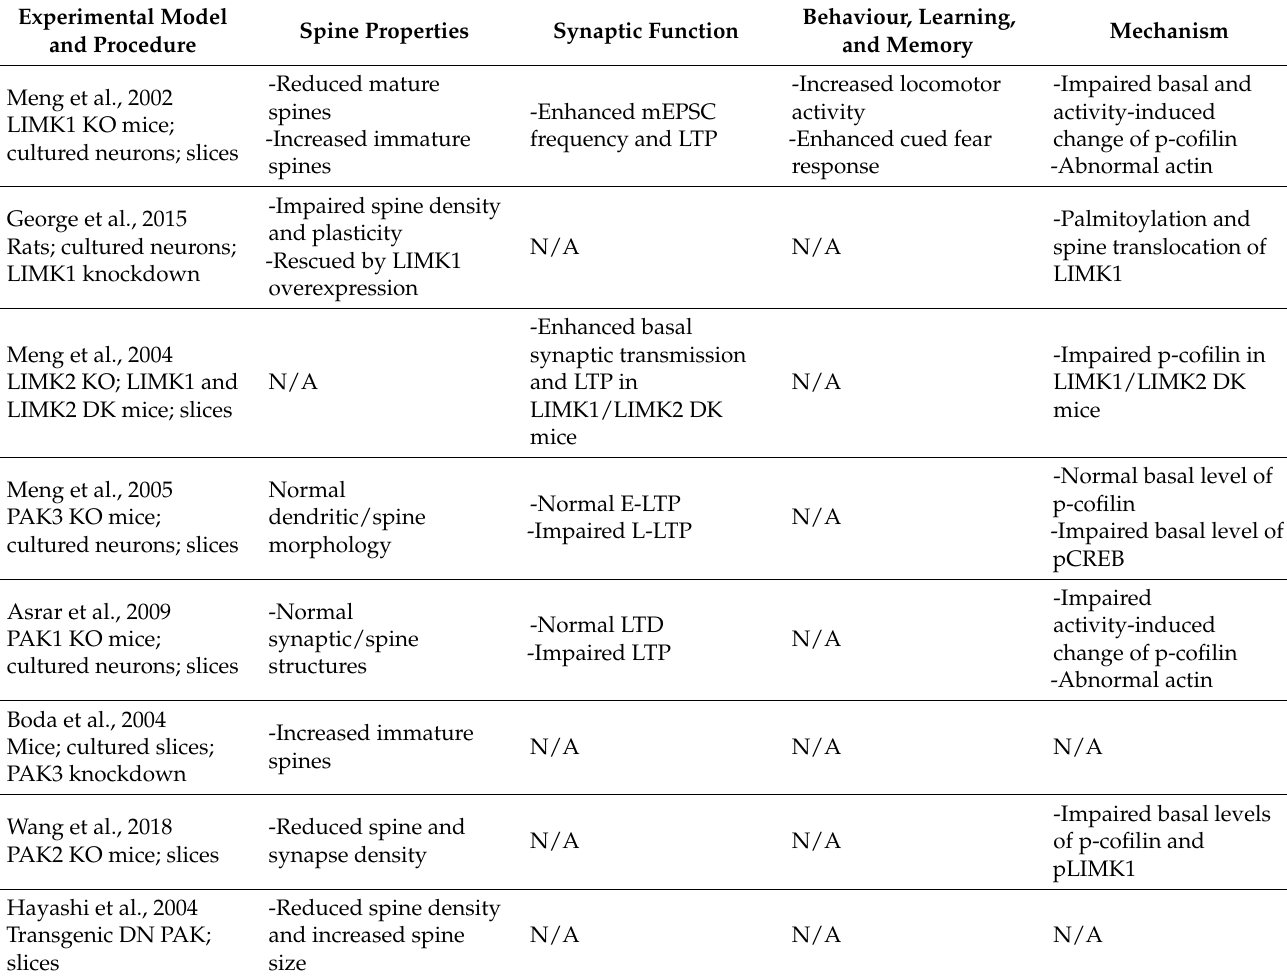
Table 1. Summary of key studies on